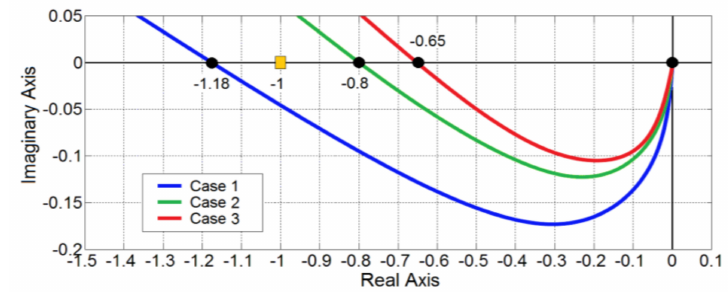
Figure 5. Nyquist diagram for the control bandwidths design.